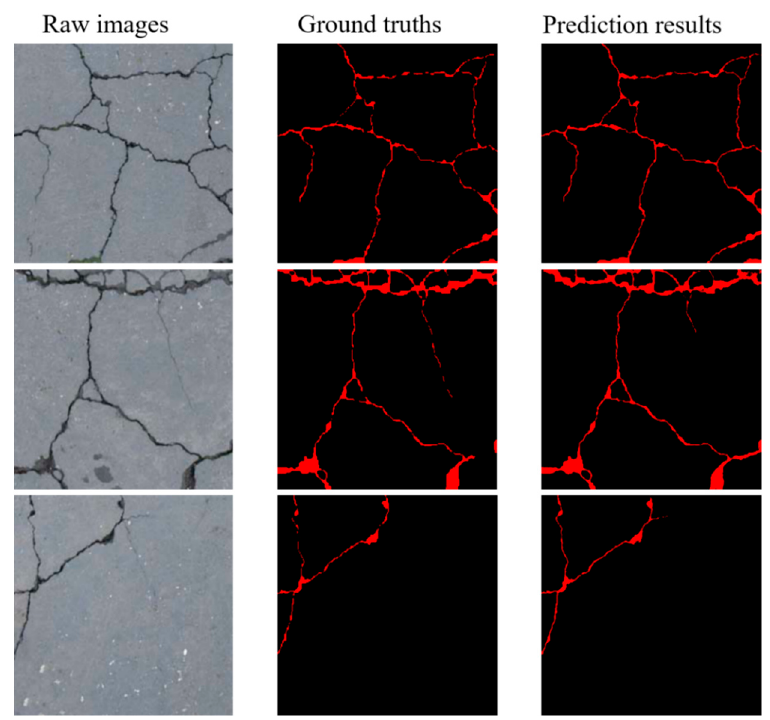
Figure 17. Examples of prediction results using proposed method on the road crack dataset.